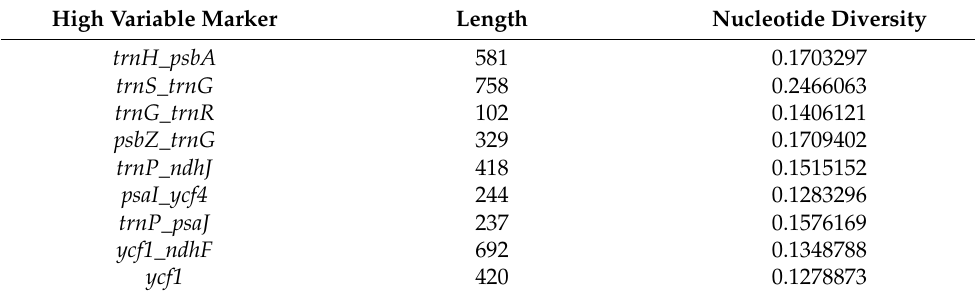
Table 6. Nine regions of highly variable sequences (Pi > 0.12) of Celastraceae species.